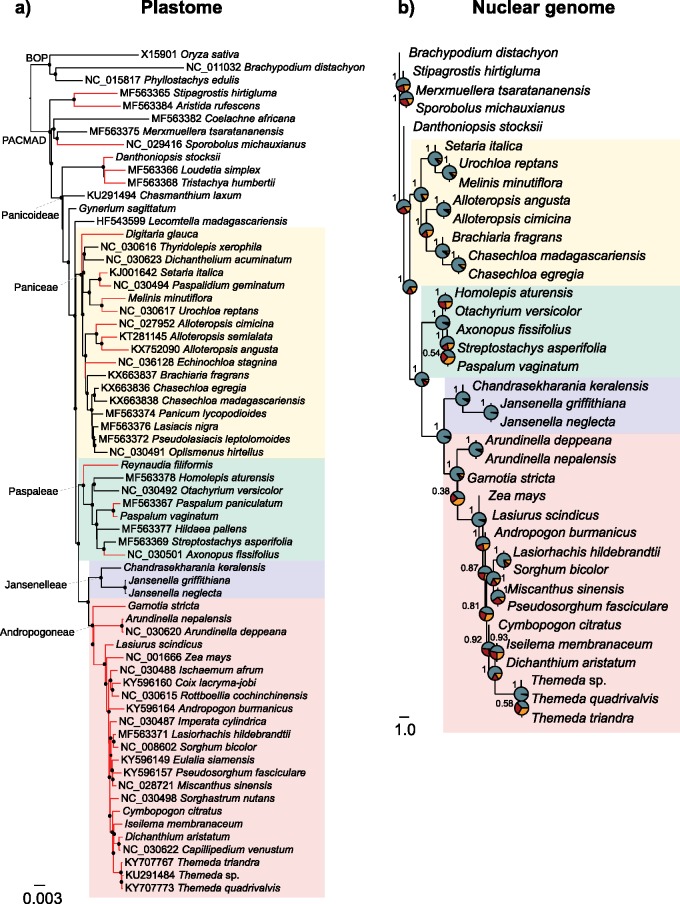
Phylogenetic trees of grasses based on (a) plastomes and (b) genome-wide nuclear data. a) Bayesian phylogram inferred from coding sequences of plastomes (see Supplementary Fig. S2 available on Dryad for phylogram based on non-coding sequences). Branch lengths are in expected substitutions per site. Closed circles on nodes indicate Bayesian posterior probability \documentclass[12pt]{minimal}
\usepackage{amsmath}
\usepackage{wasysym}
\usepackage{amsfonts}
\usepackage{amssymb}
\usepackage{amsbsy}
\usepackage{upgreek}
\usepackage{mathrsfs}
\setlength{\oddsidemargin}{-69pt}
\begin{document}
}{}$\ge.95$\end{document}. Branches in red lead to C\documentclass[12pt]{minimal}
\usepackage{amsmath}
\usepackage{wasysym}
\usepackage{amsfonts}
\usepackage{amssymb}
\usepackage{amsbsy}
\usepackage{upgreek}
\usepackage{mathrsfs}
\setlength{\oddsidemargin}{-69pt}
\begin{document}
}{}$_{4}$\end{document} species. b) Multigene coalescent species tree estimated from 365 nuclear genes. Pie charts on nodes indicate the proportion of quartet trees that support the main topology (in blue), the first alternative (in red), and the second alternative (in orange). Local posterior probabilities are indicated near nodes. Branch lengths are in coalescent units. The major groups of Panicoideae are delimited with shades.